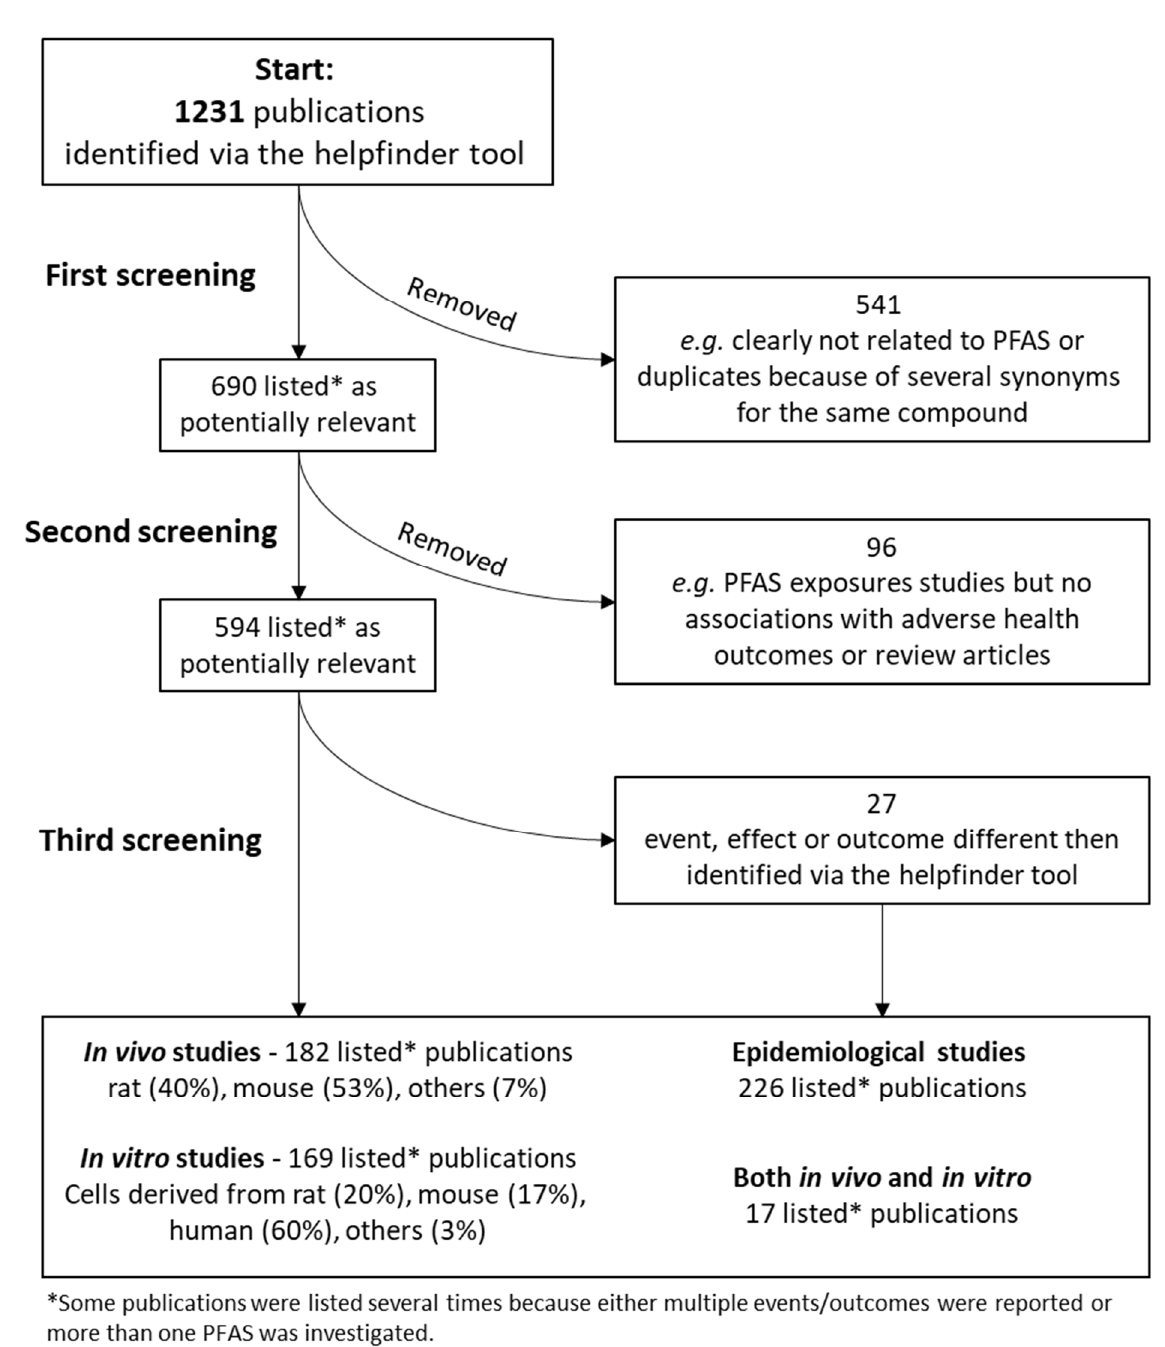
Figure 2. Flowchart of the collected publications and data using the AOP-helpFinder tool.